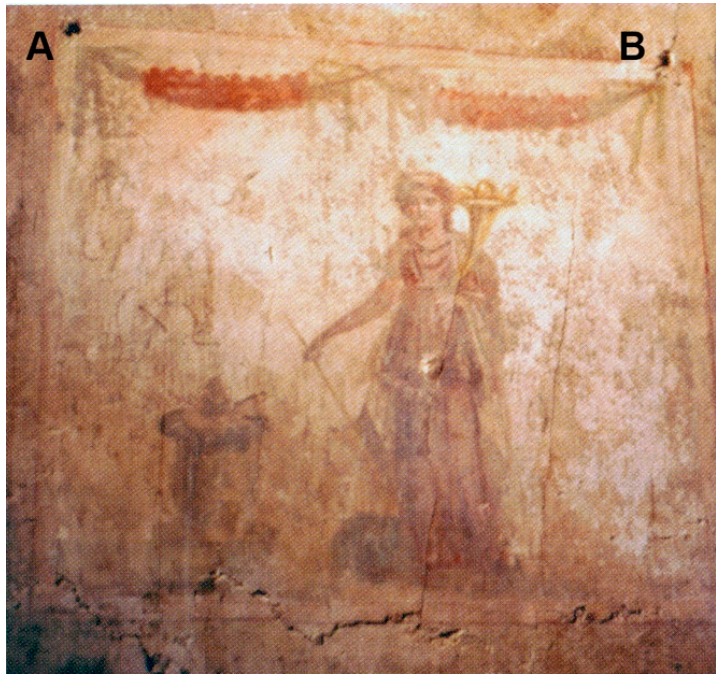
Figure 11. Suburban Baths (7.16.a), Pompeii. Fortuna with cornucopia and rudder, standing in front of an altar. Two holes for garlands indicated by letters ( A , B ). (Modified by author, after Jansen 2011, Figure 12.7).